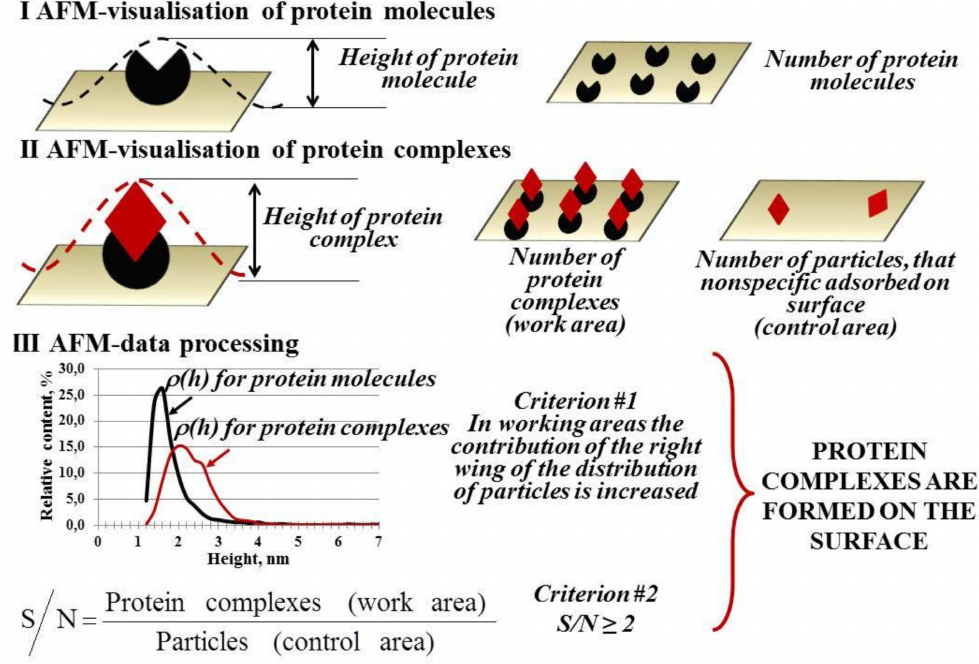
Figure 2. Sequence of stages of AFM measurements and data processing for obtaining information on stoichiometric parameters of protein macromolecules and protein complexes. At step ( I ), during the visualization by AFM, the height of biomolecules—components of protein complexes adsorbed (immobilized) on the support surface—is determined. At step ( II ), visualization of the surface after the incubation of the support in a solution of partner protein is carried out, and the height of the complexes is determined. At step ( III ) of processing of AFM data, relative distributions of the visualized objects with height ρ ( h ) are plotted, and the number of these objects per unit area is calculated. If the data obtained meet the criteria #1 and #2, the formation of protein complexes on the support surface is